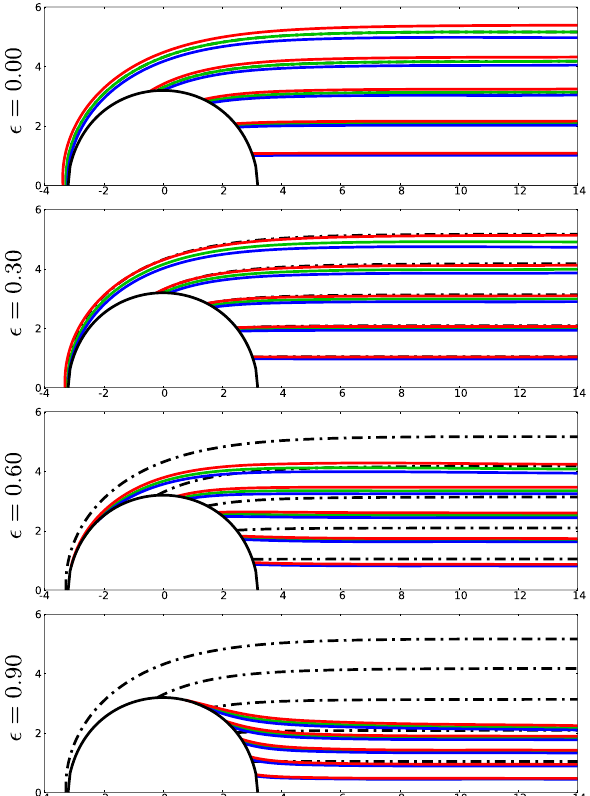
Fig. 2 Raytracing. R = 3 . 2 M , | q ∗ | = 0 . 25 M 2 , h = 3.Thedottedline corresponds to Schwarzschild without plasma, green to Schwarzschild, blue to q ∗ > 0 and red to q ∗ < 0. As the ratio (cid:11) = ω e ( R )/ω( R ) increases, both the apparent size of the star b max and the maximum angle of visibility θ max decrease. We see that b max and θ max increases for q ∗ < 0 and decreases for q ∗ > 0, with Schwarzschild metric in between